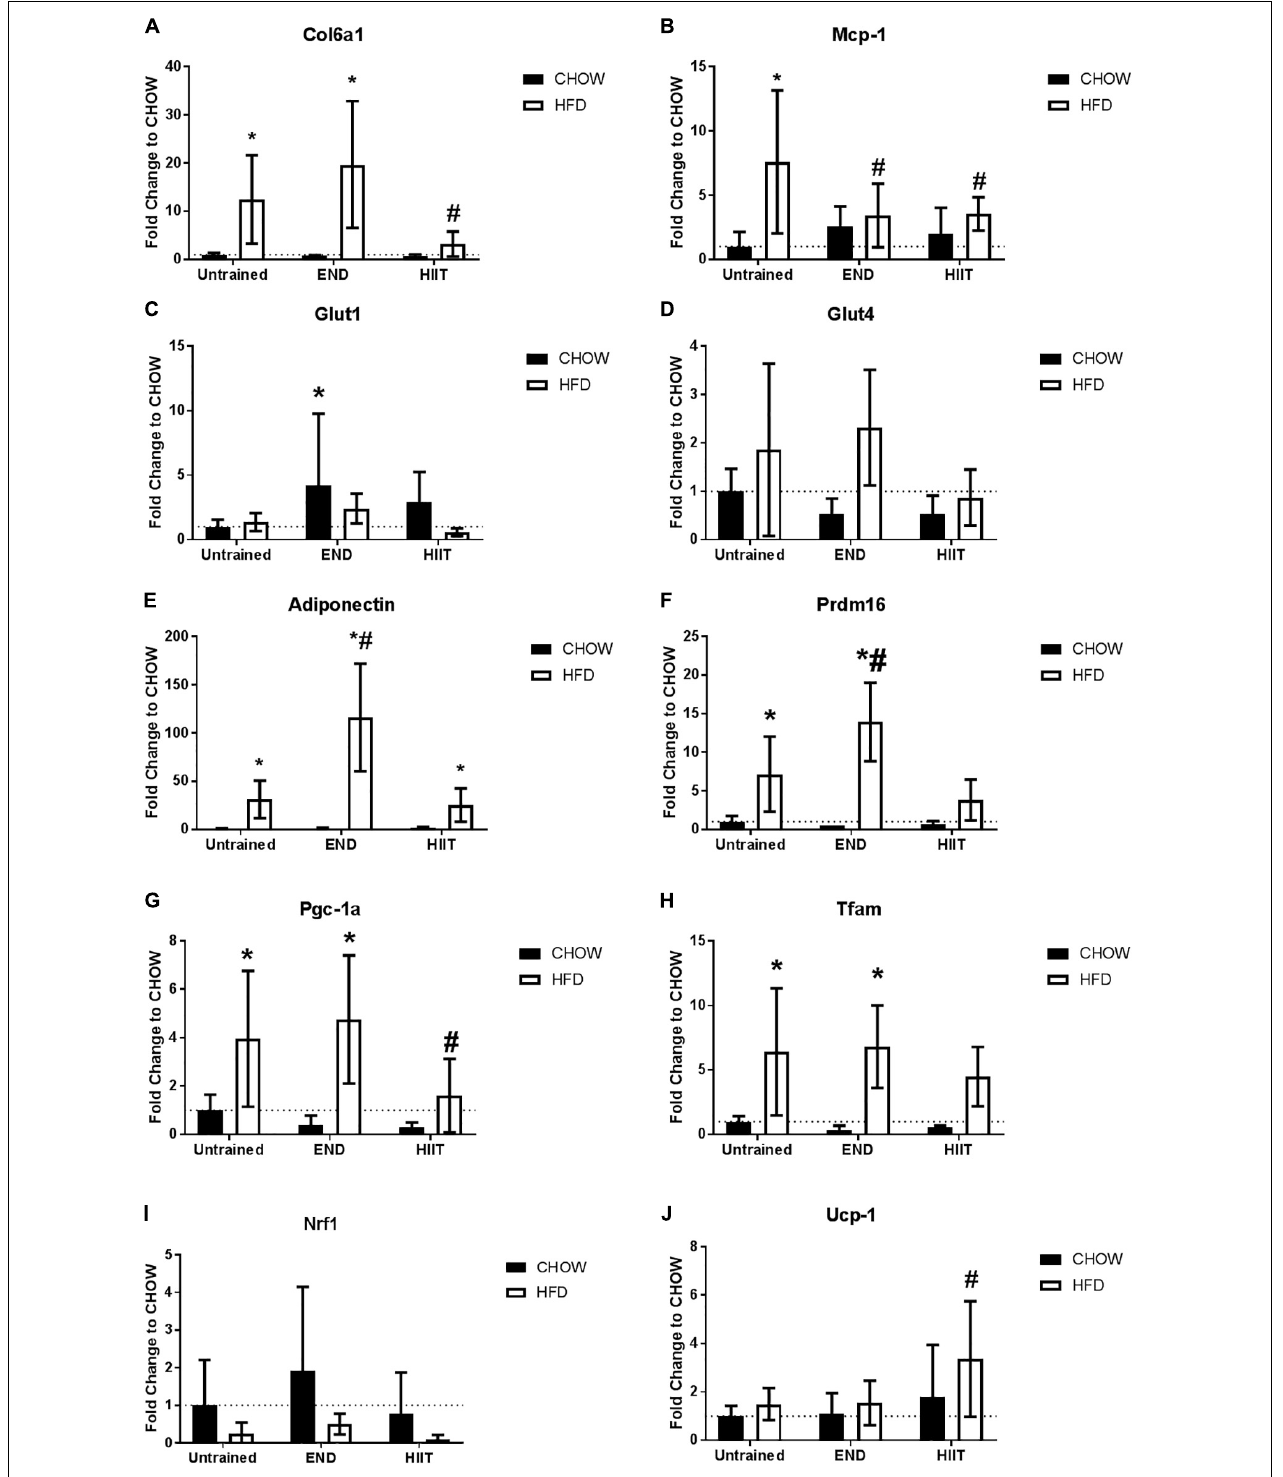
FIGURE 6 | Subcutaneous adipose tissue mRNA levels of metabolism-related genes. Collagen VI alpha 1 (Col6a1; A ), monocyte chemotactic protein-1 (Mcp-1; B ), Glut1 receptor (C) , Glut4 receptor (D) , Adiponectin (E) , PR domain containing 16 (Prdm16; F ), peroxisome proliferator-activated receptor gamma coactivator 1-alpha (Pgc-1 alpha; G ), Mitochondrial transcription factor A (Tfam; H ), Nuclear respiratory factor 1 (Nrf1; I ), and uncoupling protein 1 (Ucp-1; J ). Data are presented as means ± SD and the number of animals in each group is 6–12. ∗ p < 0.05 vs. CHOW untrained; # p < 0.05 vs. HFD untrained by Two-way ANOVA with Tukey’s and Sidak’s post hoc